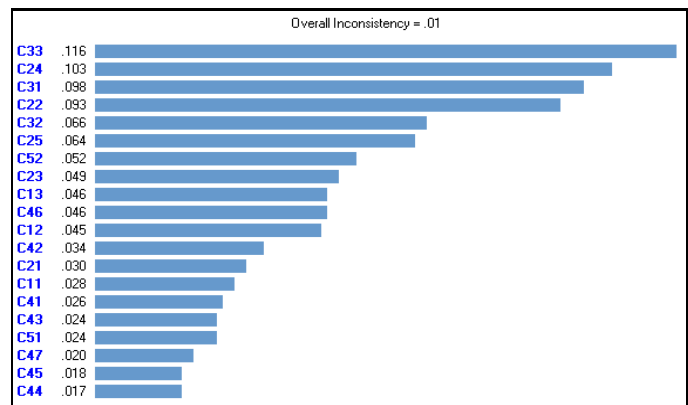
Fig. 8. Final weight and rank of